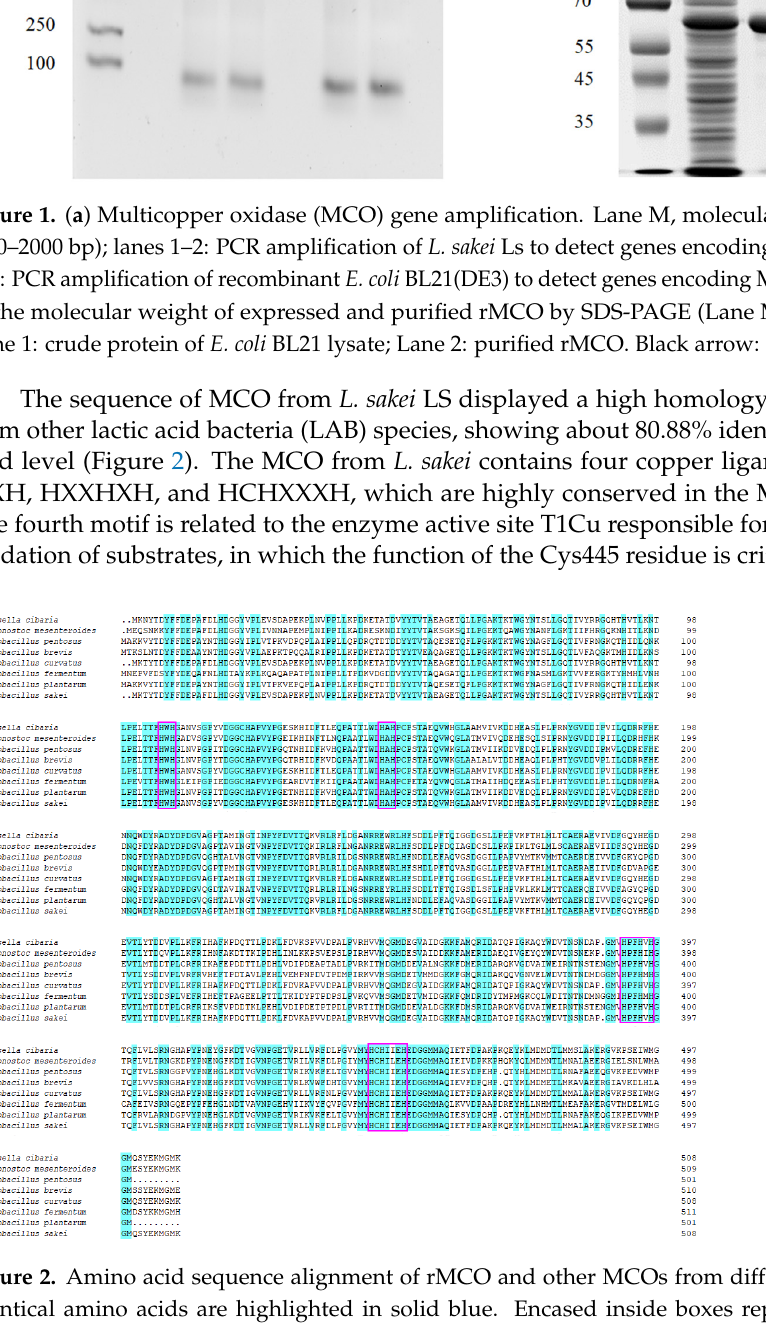
Figure 3. Predicted 3D structure model of the rMCO. The three copper centers are highlighted. The yellow balls stand for Cu 2+ in the active site. 3.2. Enzymatic Characterization of rMCO ABTS was used as the typical substrate to evaluate the enzymatic characteristics of MCO. In this study, the effect of pH and temperature on the catalytic activity of rMCO towards ABTS was investigated and presented in Figure 4. The highest oxidation activity of rMCO was found at pH 3.0 and 25 °C. Under this optimum condition, the specific ac- tivity of the purified rMCO was around 1.27 U/mg. The optimum condition was different from other bacterial MCOs. For example, the laccase from Bacillus velezensis TCCC 111904